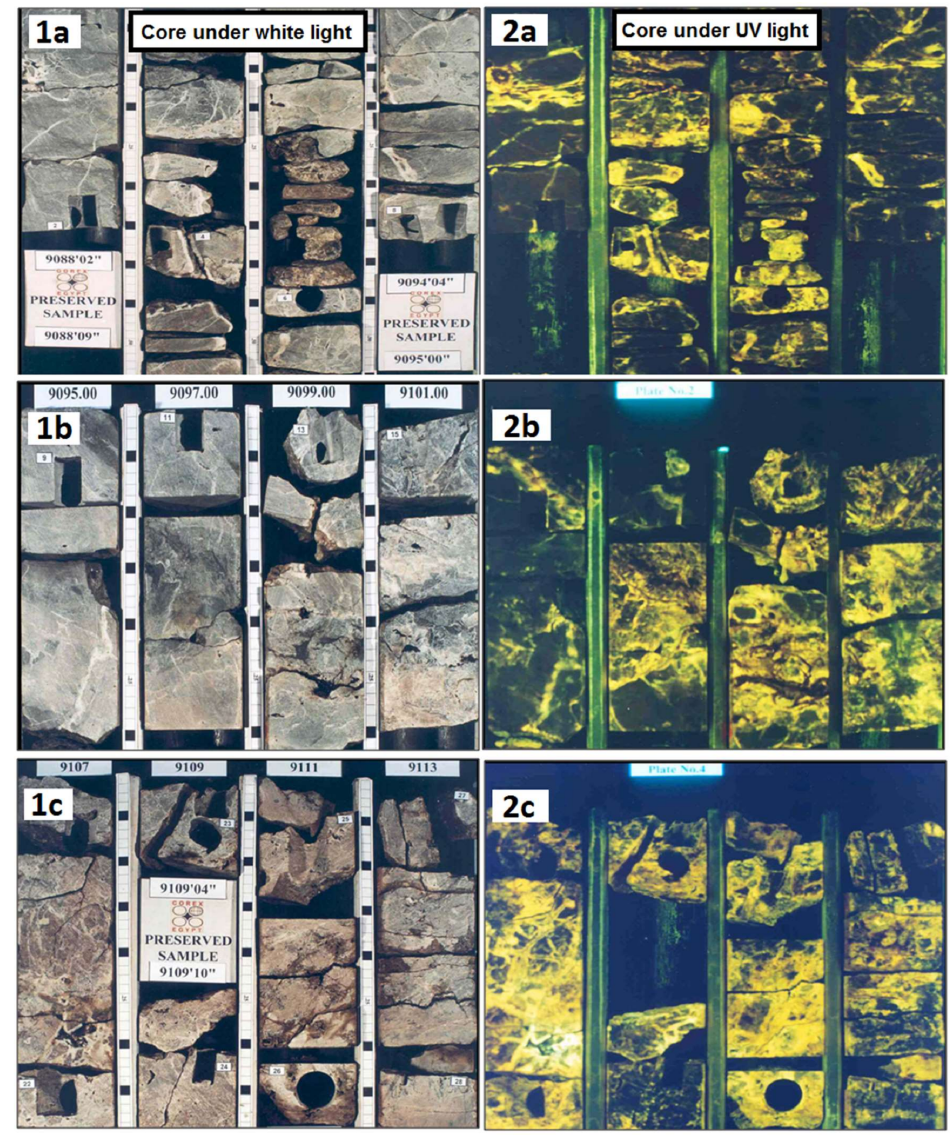
Figure 9. Photographs of core samples from the N.Alamein-5X well under white ( 1a – 1c ) and ultra violet ( 2a – 2c )